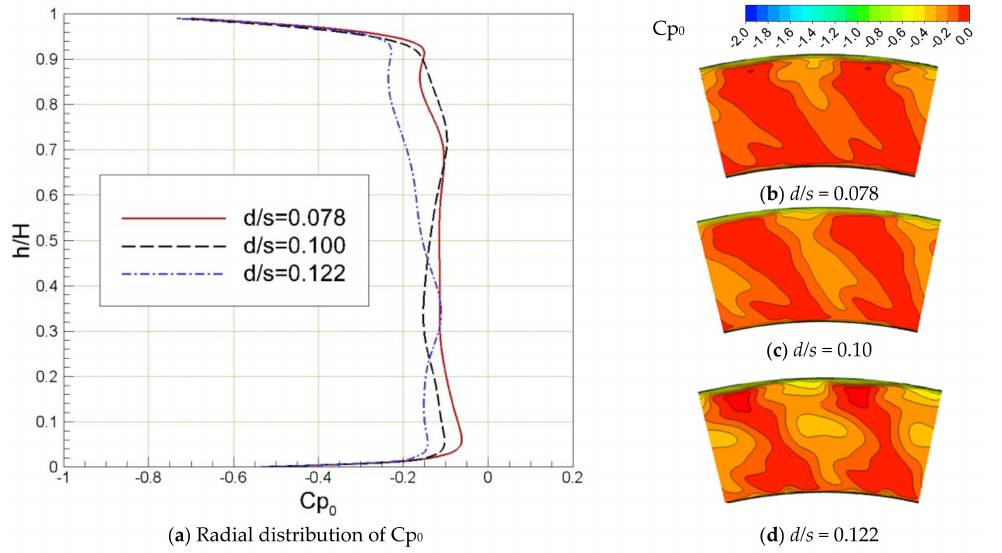
Figure 11. Distribution of the pitchwise mass-averaged total pressure coefficient and its contour in Section